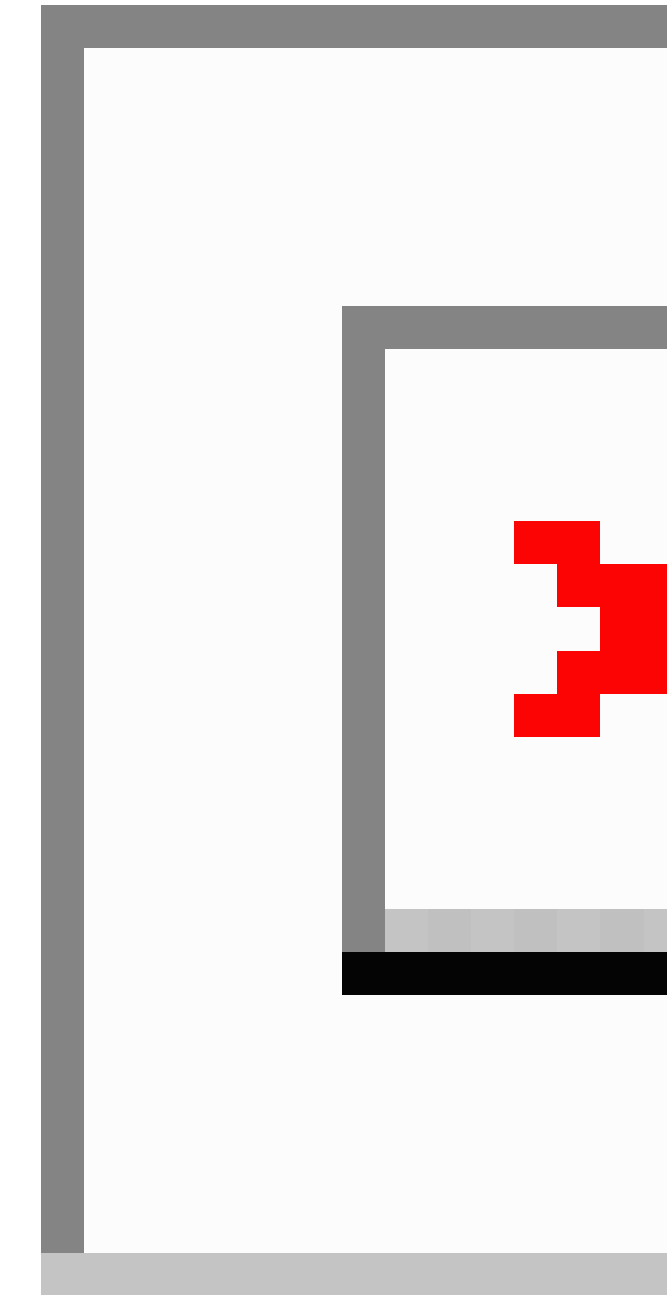
Figure 1. Beyond-Getting Rid of Stupid Stuff (GROSS) flow